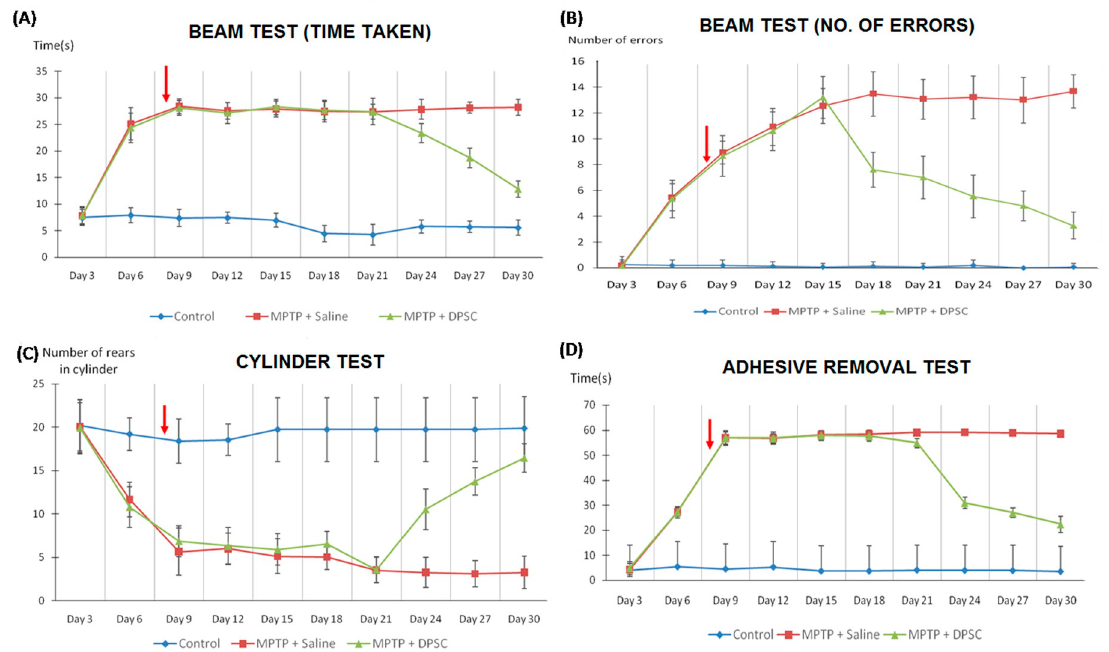
Figure 3. Control, MPTP-induced and DPSC-administered MPTP mice were tested for sensorimotor coordination on the challenging beam traversal, spontaneous activity in cylinder and adhesive removal tests. ( A ) The time taken to traverse the beam, ( B ) the number of errors made per step, ( C ) the number of spontaneous rears made on the hindlimbs and ( D ) the time taken to make contact with the sensory stimuli were measured. MPTP mice took longer to traverse the beam and made more errors during steps compared with the control mice in the beam test. In addition, MPTP mice were less active in the cylinder test and were significantly slower to respond to sensory stimuli compared with the control mice in the adhesive removal test. However, performance was significantly improved in MPTP mice across all measures following DPSC delivery (red arrow) at Day 7 ( p < 0.001). Values are expressed as mean ±